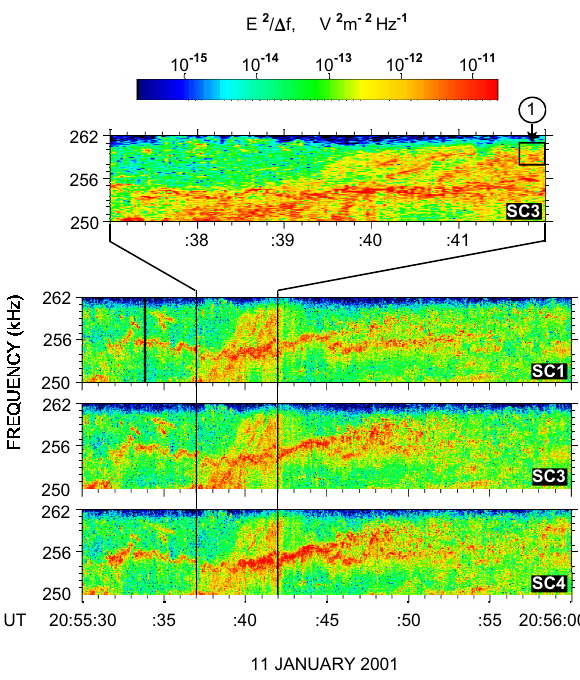
Fig. 12. AKR spectra recorded on spacecraft SC1, SC3, and SC4 on 11 January 2001 between 20:55:30 and 20:56:00UT. The upper panel is an enlargement of the five-second time range 20:55:37 to